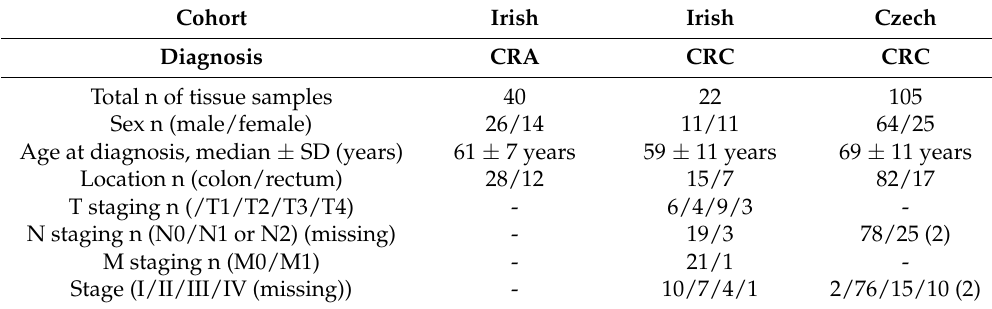
Table 1. Clinical-pathological characteristics of the studied cohort of patients. Cohort Irish Irish Czech Diagnosis CRA CRC CRC